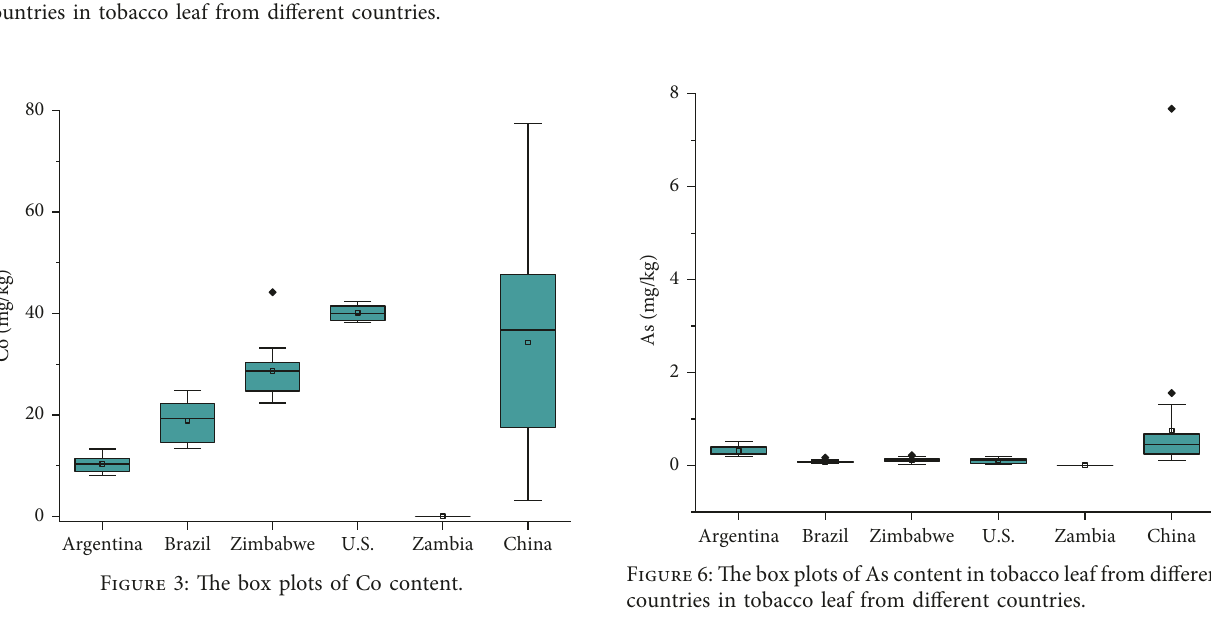
Figure 5: The box plots of Ni content.